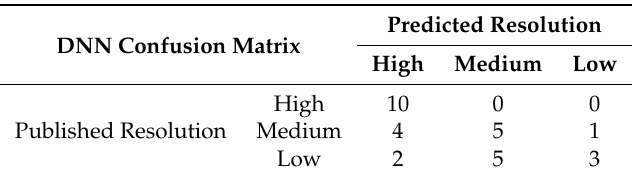
Table 3. DNN confusion matrix.